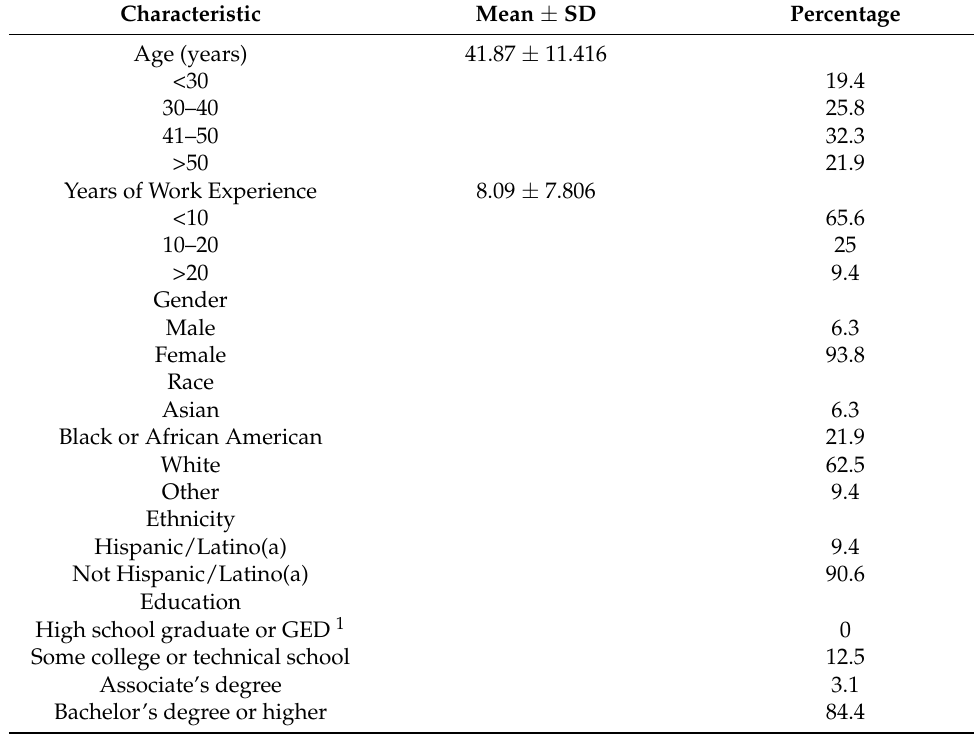
Table 1. Community Stakeholders’ Demographic Characteristics ( n =